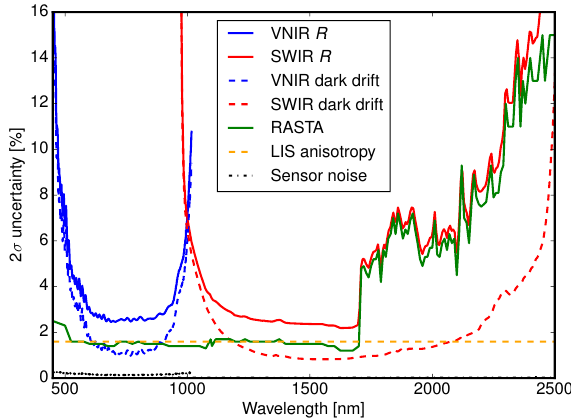
Figure 12. Main contributions to the 2 σ uncertainty of the abso- lute radiometric response R . The uncertainties resulting from sen- sor noise and dark current drift are shown for the RASTA measure- ments. Due to the lower radiance of the RASTA, other noise and drift components contribute less to the total